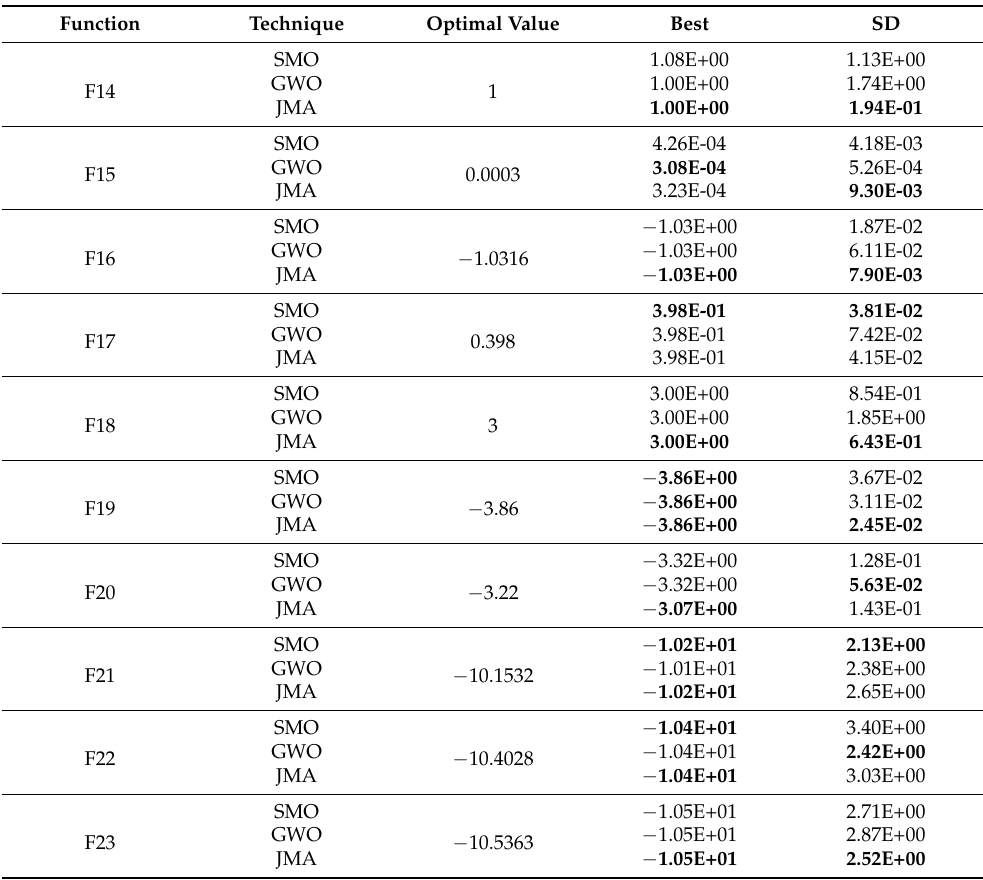
Table 7. Experimental results of the fixed-dimension multimodal benchmark